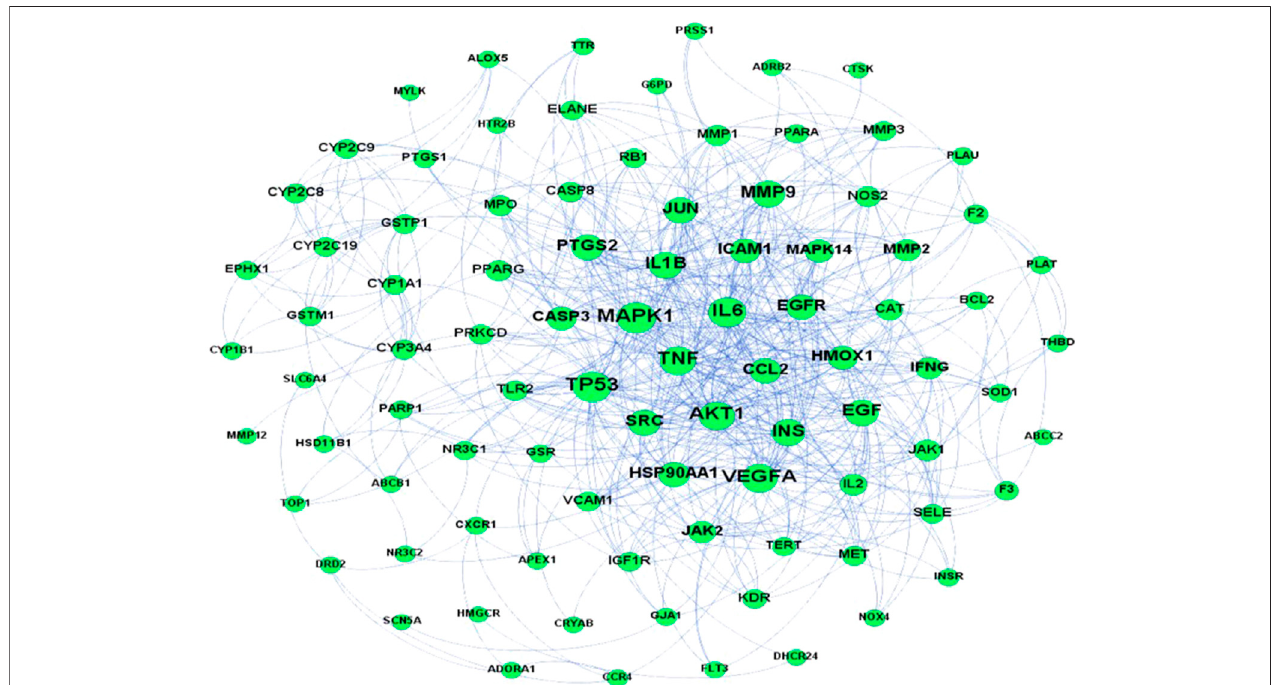
FIGURE 4 | PPI network of potential pulmonary fi brosis targets acted upon by major ingredients of H. cordata .